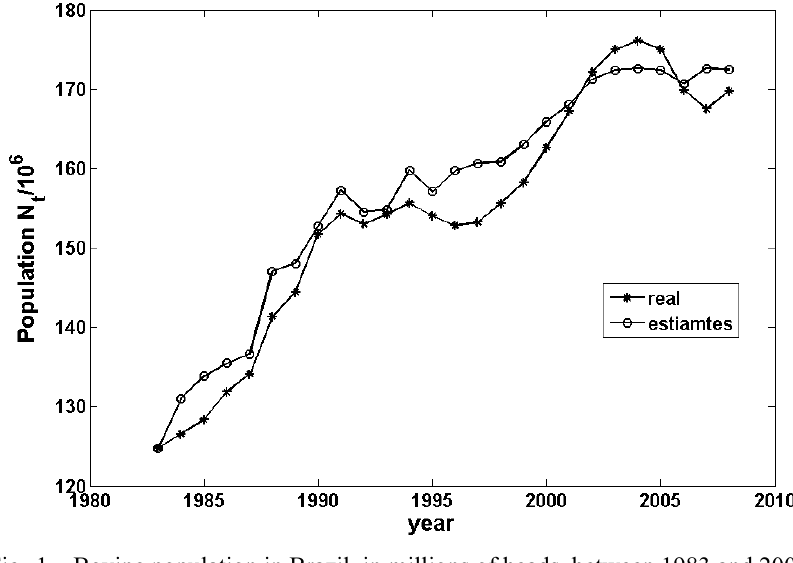
Fig. 1 – Bovine population in Brazil, in millions of heads, between 1983 and 2008.